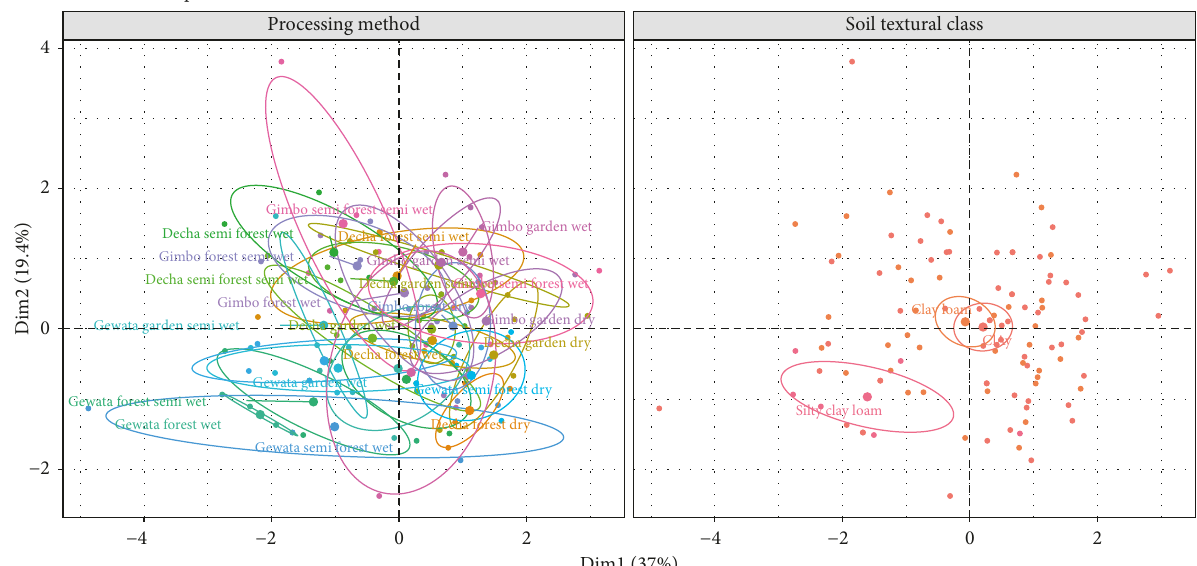
Figure 3: Individual coffee samples and their relationship with the coffee processing systems and soil textural